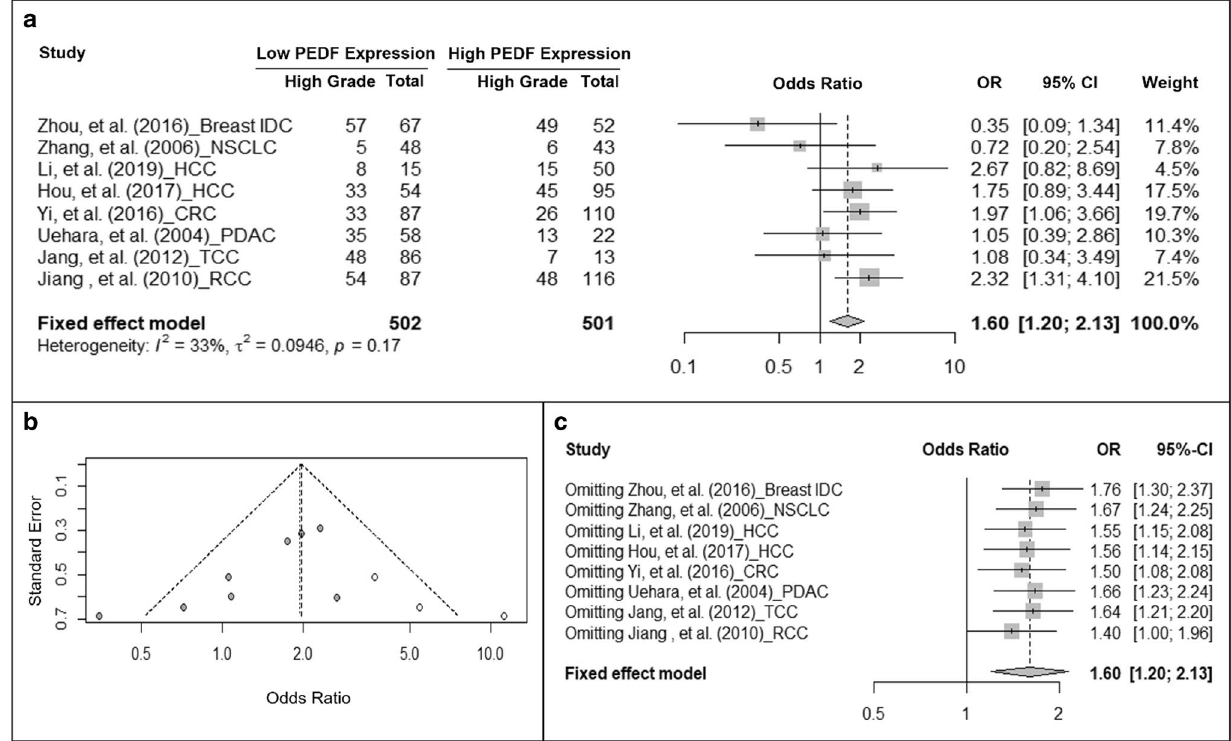
Fig. 5 Cancer with low PEDF expression has increased odds to have higher pathological grade. a Forest plot showing the association of PEDF expression and tumor pathological grade. Squares indicate study-specific odds ratios (ORs). The size of the box is proportional to the weight of the study. Horizontal lines indicate 95% confidence interval (CI). A diamond indicates the summary OR with its corresponding 95% CI. b Funnel plot on the publication bias of studies on PEDF expression and tumor pathological grade. Each filled circle represents one study. Open circles represent filled studies to correct publication bias. c Forest plot of sensitivity test. Squares indicate the summary OR after omitting one specific study. Horizontal lines indicate 95% CI. A diamond indicates the summary OR of all the studies with its corresponding